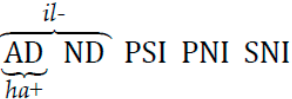
Figure 5. Reference Hierarchy for Kuwaiti.